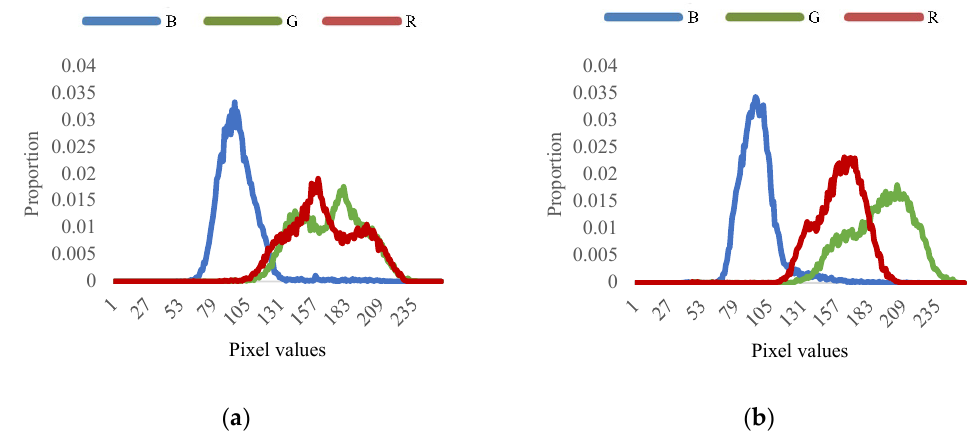
Figure 17. Color histogram of pear surface image. ( a ) Color histogram of standard color. ( b ) Color histogram of deviant color.